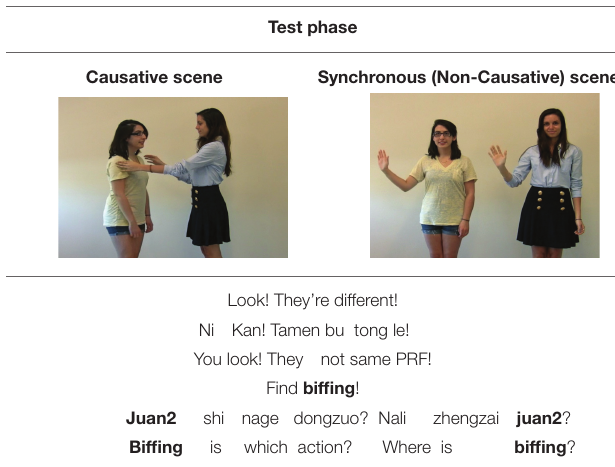
Table 3 for means and standard deviations for all